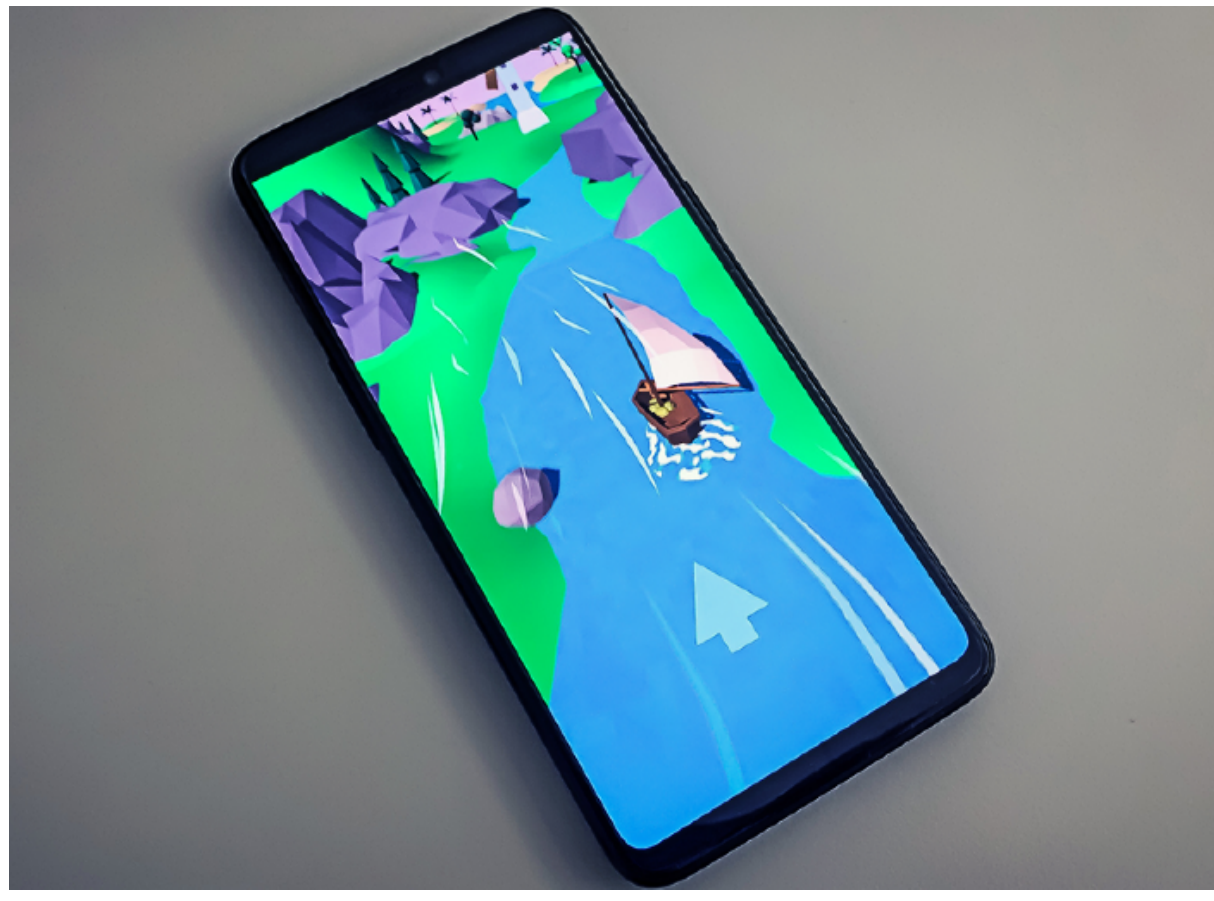
Figure 1. Our developed mobile gameful biofeedback breathing training Breeze running on a